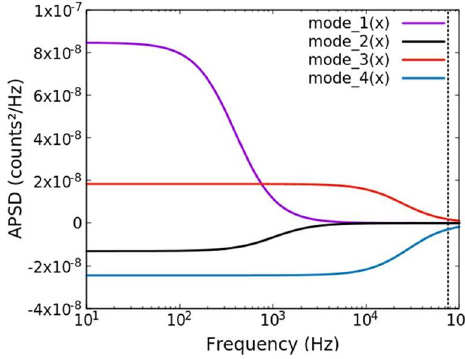
Figure 3. Partial Mode Contributions for the Total APSD for the 286.6 ppm